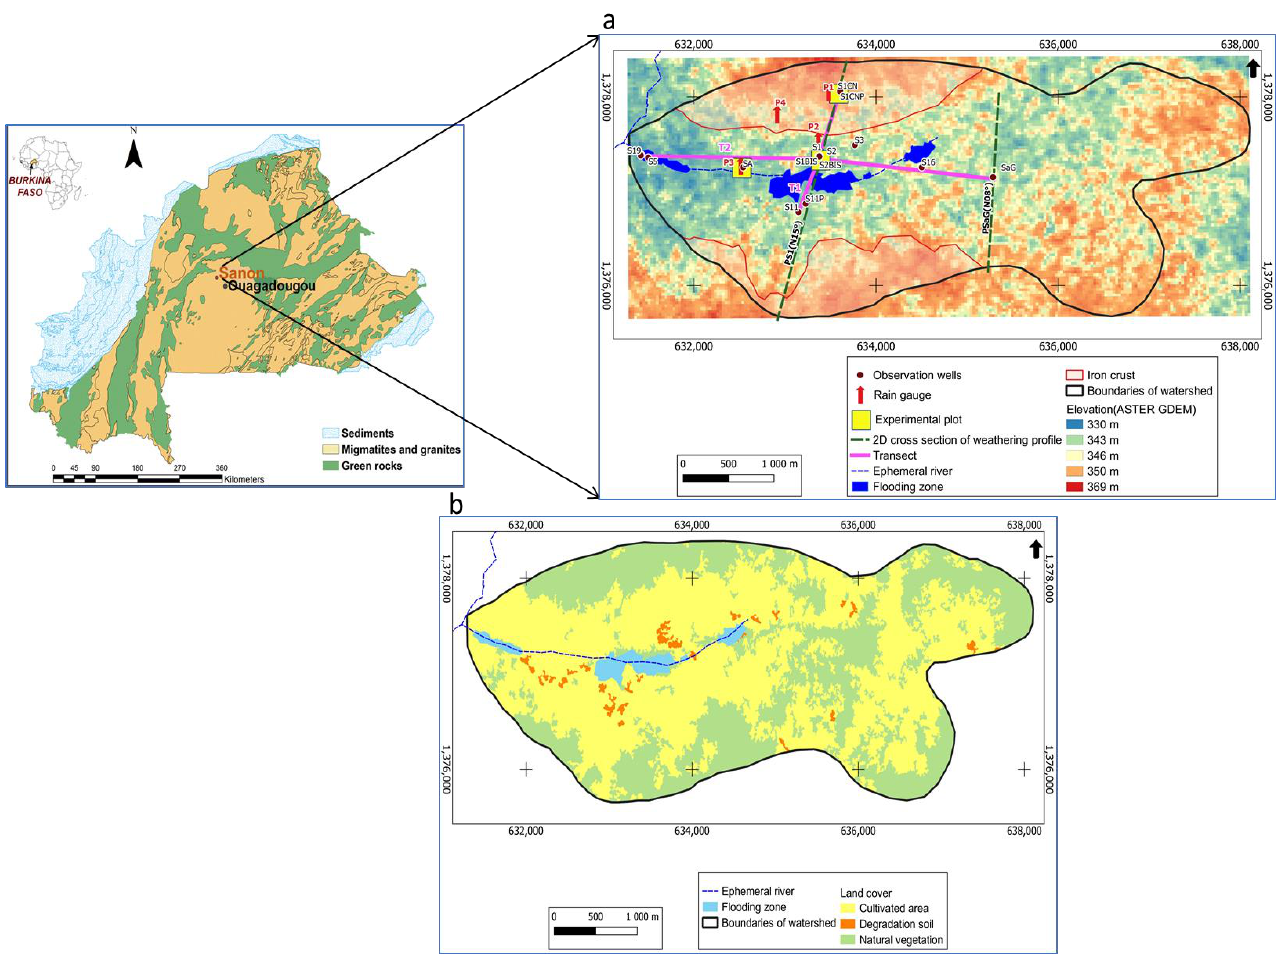
Figure 1. Location of the Sanon experimental catchment area in central Burkina Faso. ( a ) Elevation, hydrography, location of observation wells, rain gauges (P1 to P4), and 2D cross-sections of the weathering profile (PSaG and PS1); ( b ) land cover in the Sanon catchment area [51].